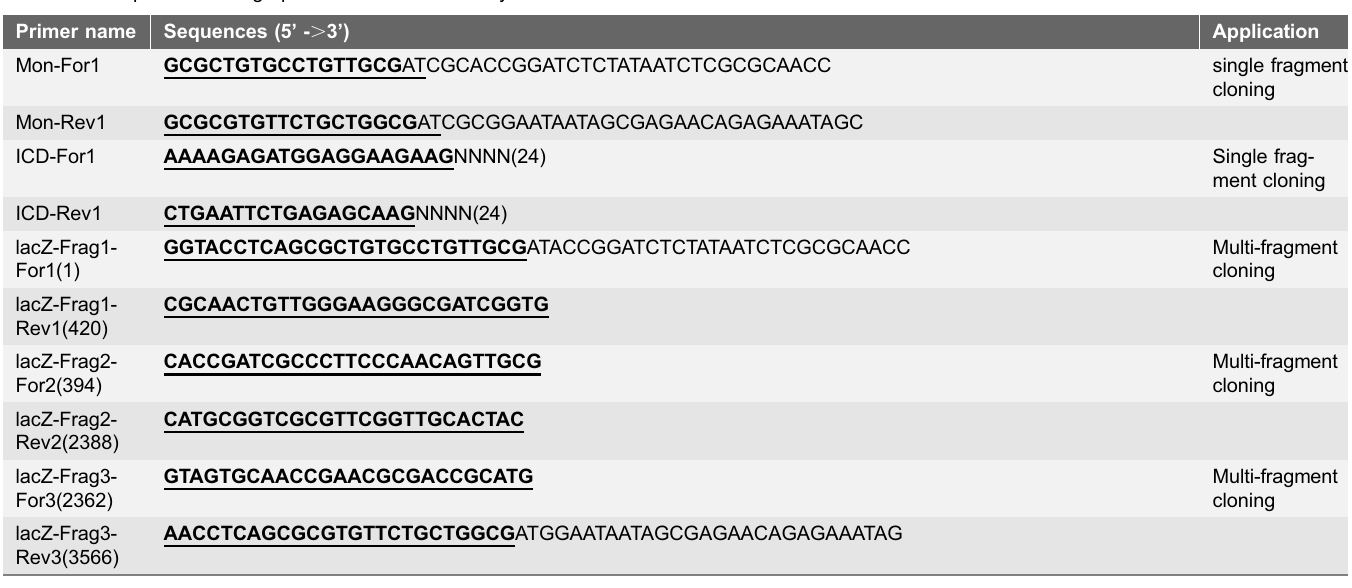
Table 1. Examples of the oligo primers used in this